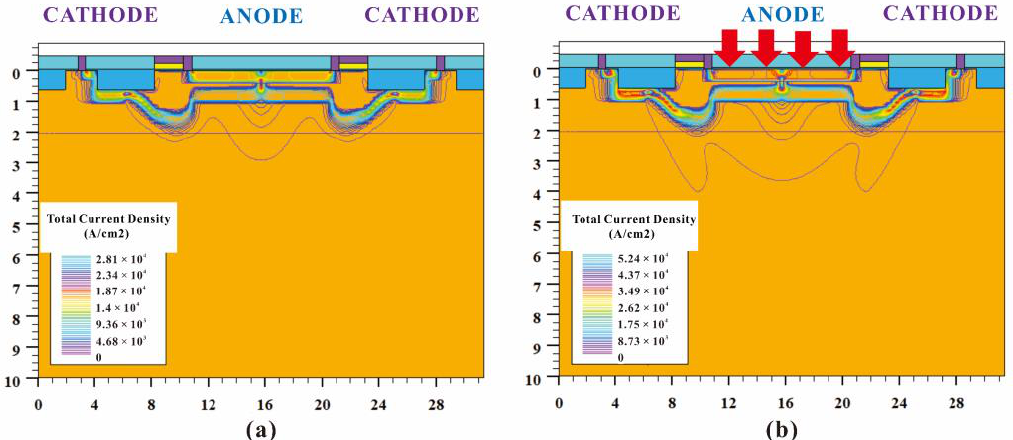
Figure 4. Current distribution of HDEPD device under light-free conditions ( a ) and current distribution of HDEPD device under light conditions ( b ).